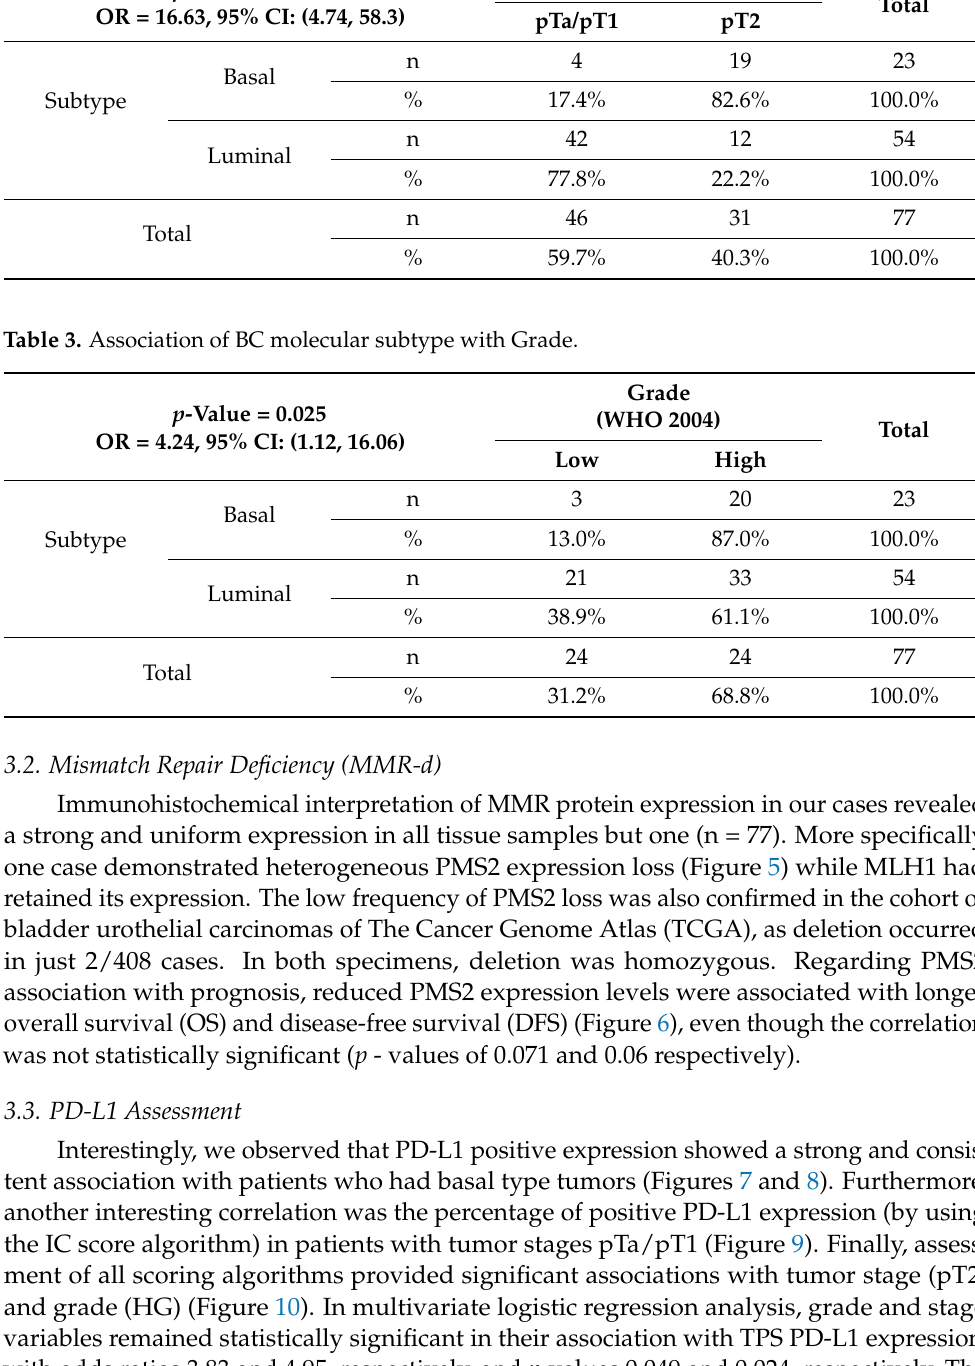
Table 2. Association of BC molecular subtypes with stage. p -Value < 0.001